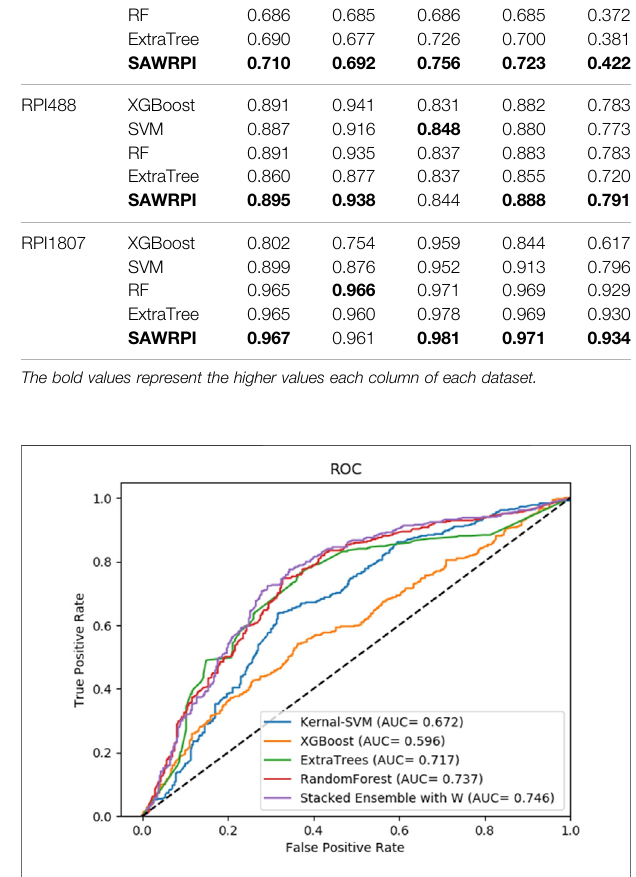
FIGURE 4 | Average result of ROC curves of fi ve-fold cross-validation with four single base classi fi ers and our method of stacking ensemble on RPI369 by SAWRPI. AUC expresses area under an ROC curve.